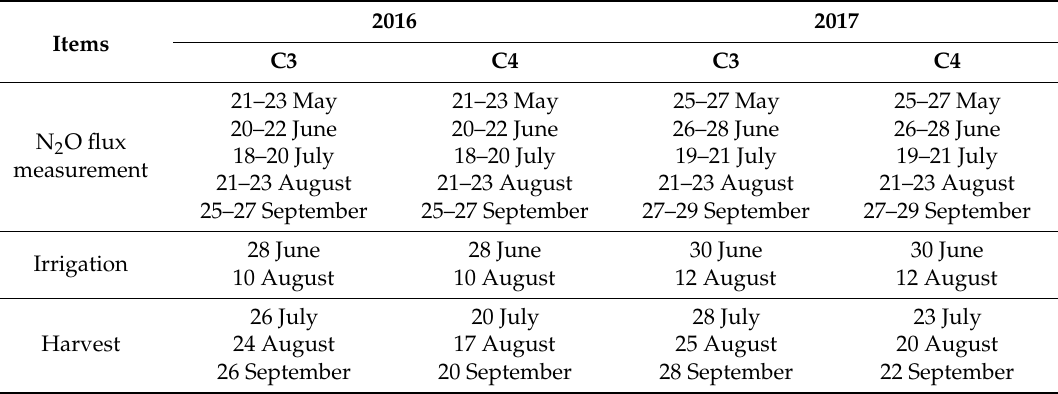
Table 1. The schematic timeline of the N 2 O flux measurements, irrigation events and harvests for